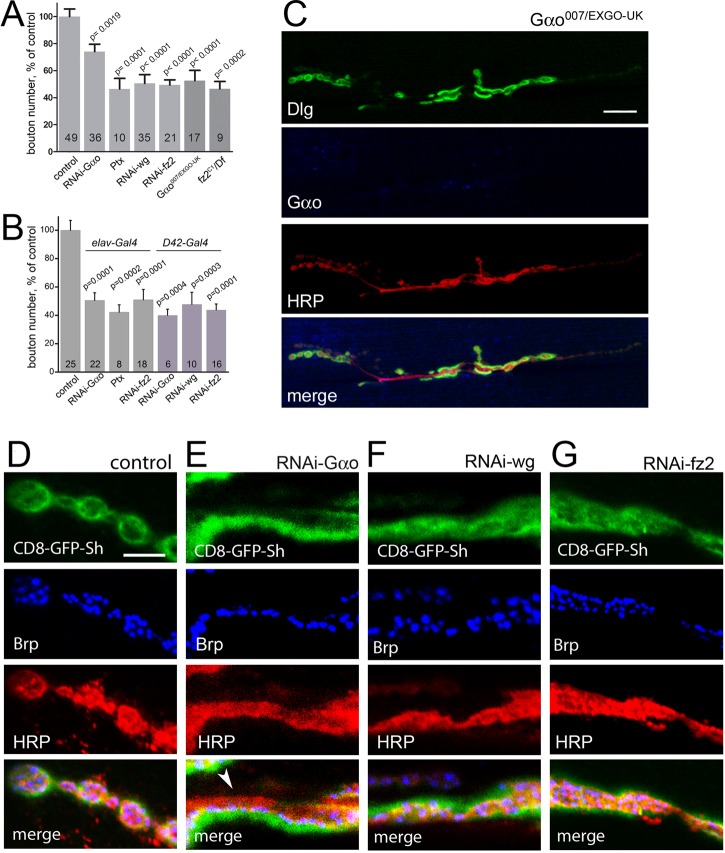
Gαo is required for NMJ formation, similar to Wg and Fz2. (A) Quantitative analysis of bouton number on muscle 6/7. Presynaptic downregulation of Gαo, Wg and Fz2 with the driver OK371-Gal4, expression of Ptx, as well as genetic removal of Gαo or Fz2 lead to a significant decrease in bouton number compared with the wild type (control). Data are represented as percentage of control; the number of NMJs analyzed for each genotype is shown in each bar; P-values compared with the control are indicated; error bars indicate s.e.m. (B) Downregulation of Gαo or Fz2 and expression of Ptx with the pan-neuronal driver elav-Gal4 similarly decrease bouton numbers. The same effect is observed when RNAi against Gαo, wg or fz2 is driven with motoneuron-specific D42-Gal4. (C) Genetic removal of Gαo leads to a strong reduction in bouton number and aberrant NMJ morphology (compare with Fig. 1A-F). Anti-Gαo staining (blue) confirms loss of the proteins; the remaining signal is non-specific. (D-G) Presynaptic downregulation of Gαo, Wg or Fz2 results in malformed boutons. Displayed is a detail of the NMJ on muscle 6/7 that is stained with anti-HRP to visualize the presynaptic cell membrane in red, with anti-Brp to stain the active zones in blue, and the postsynaptic marker CD8-GFP-Sh in green. All mutant genotypes lead to the development of elongated structures with defective overlap of pre- and postsynapse (E, arrowhead) instead of the circular postsynaptic boutons with postsynaptic staining encircling presynaptic staining as in the wild type (D). Scale bars: 20 µm in C; 5 µm in D-G.